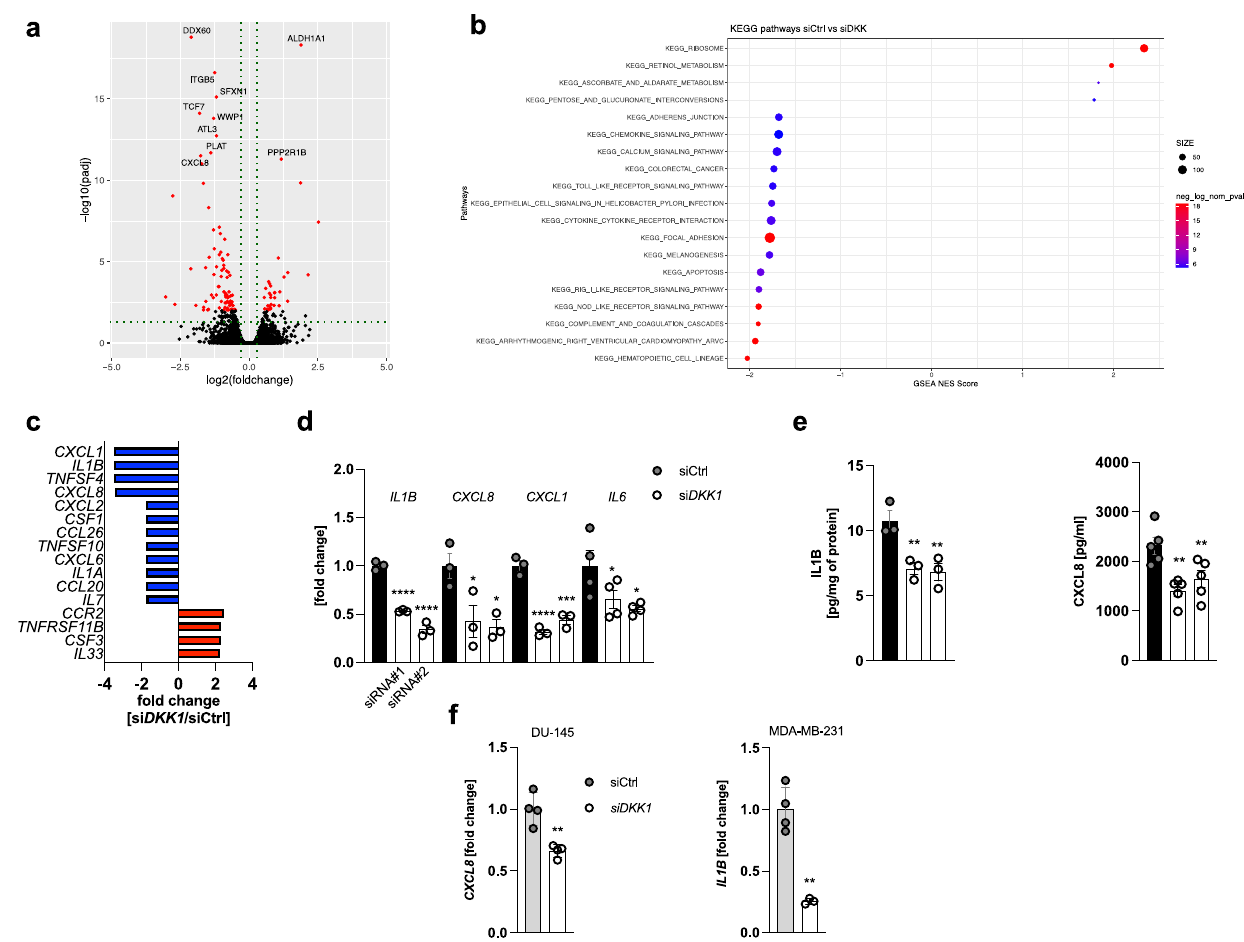
Fig. 2 Suppression of DKK1 production curtails in fl ammatory cytokine expression in cancer cells. a Differential expression analysis of RNAseq data from DKK1-de fi cient and wild-type PC3 cells (siDKK1 and siCtrl, respectively) visualized as a volcano plot. Signi fi cantly differentially expressed genes are highlighted in red ( n = 3/genotype). b Results from Gene Set Enrichment Analysis (GSEA) visualized as a bubble plot. c Pro-in fl ammatory cytokine and chemokine PCR array from DKK1-de fi cient (siDKK1) and DKK1-competent (siCtrl) PC3 cells. The most differentially regulated transcripts are shown (mean of n = 3/genotype is shown). d Quanti fi cation of selected cyto-/chemokines by qPCR analysis in DKK1-de fi cient and -competent PC3 cells. Results for two independent DKK1-targeting siRNAs are shown (referred to as siDKK1#1 and siDKK1#2 and visualized as two separate bars across all fi gures) ( n = 3/ genotype). e IL1B and CXCL8 protein levels in total cell lysates and cell culture supernatants from PC3 cells with or without DKK1 knockdown. IL1B remained undetectable in cell culture supernatants ( n = 3 – 5/genotype). f CXCL8 and IL1B mRNA expression in DU-145 prostate and MD-MB-231